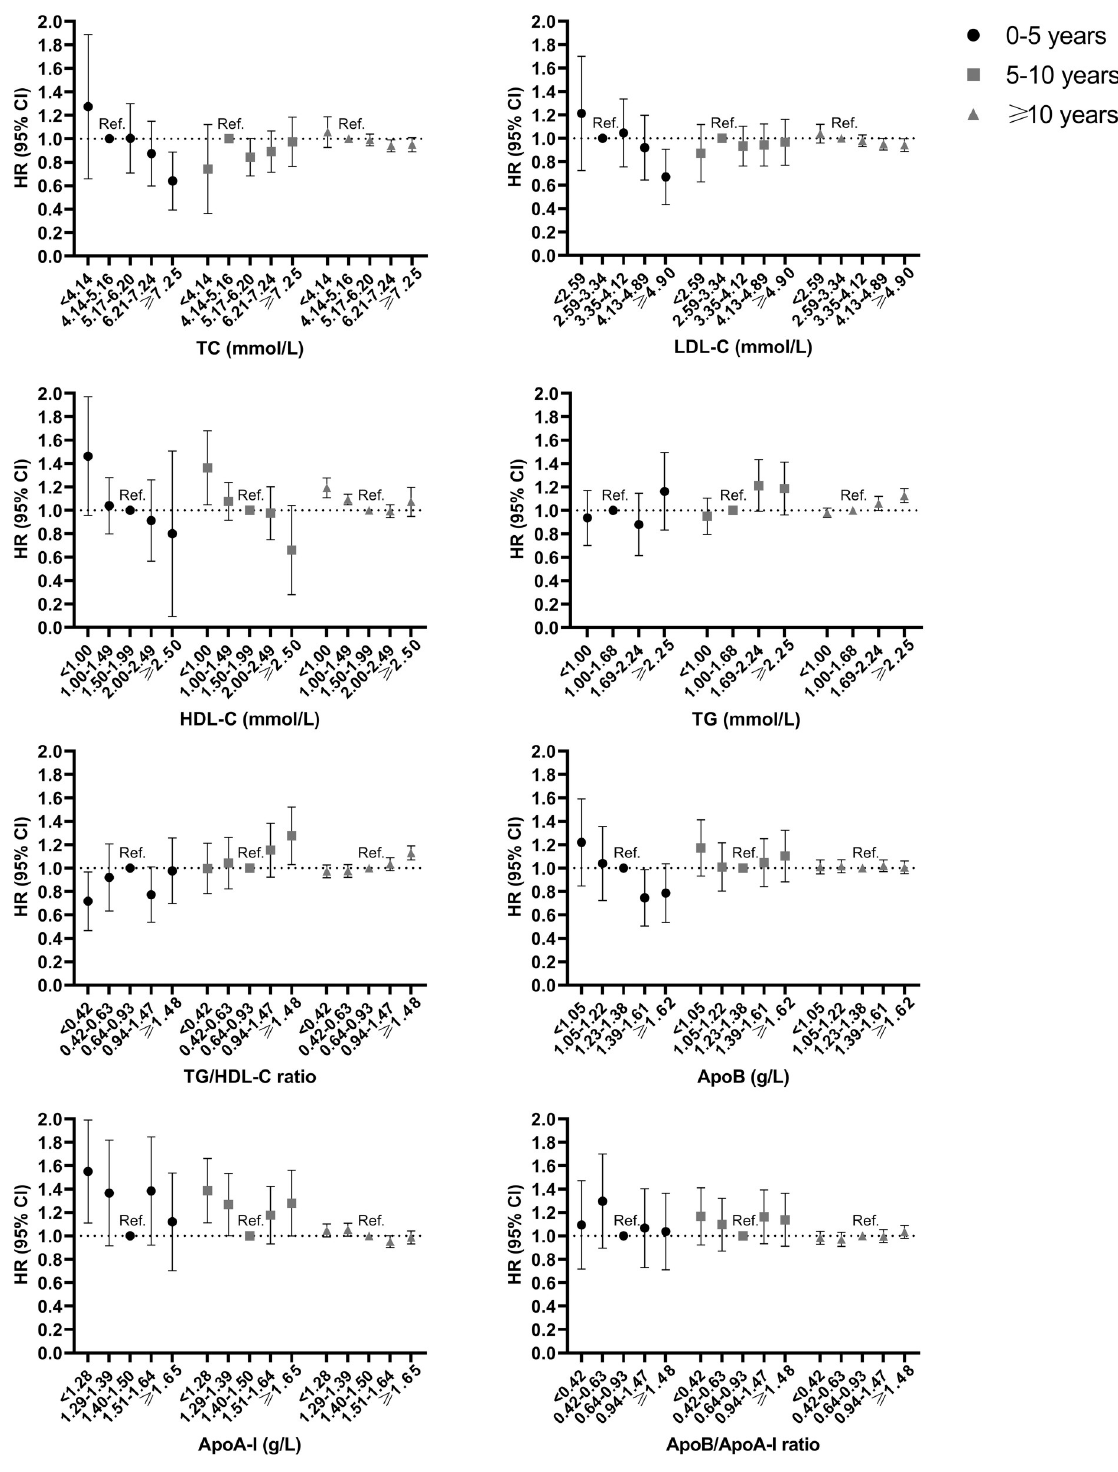
Fig 4. HR (95% CI) for incident AF associated with lipid biomarkers in categories, stratified by periods of follow-up (i.e., 0–5 years, 5–10 years, and � 10 years). All models are adjusted for age, sex, and SES at baseline. AF, atrial fibrillation; ApoA-I, apolipoprotein A-I; ApoB, apolipoprotein B; CI, confidence interval; HDL-C, high-density lipoprotein cholesterol; HR, hazard ratio; LDL-C, low-density lipoprotein cholesterol; SES, socioeconomic status; TC, total cholesterol; TG, triglycerides.